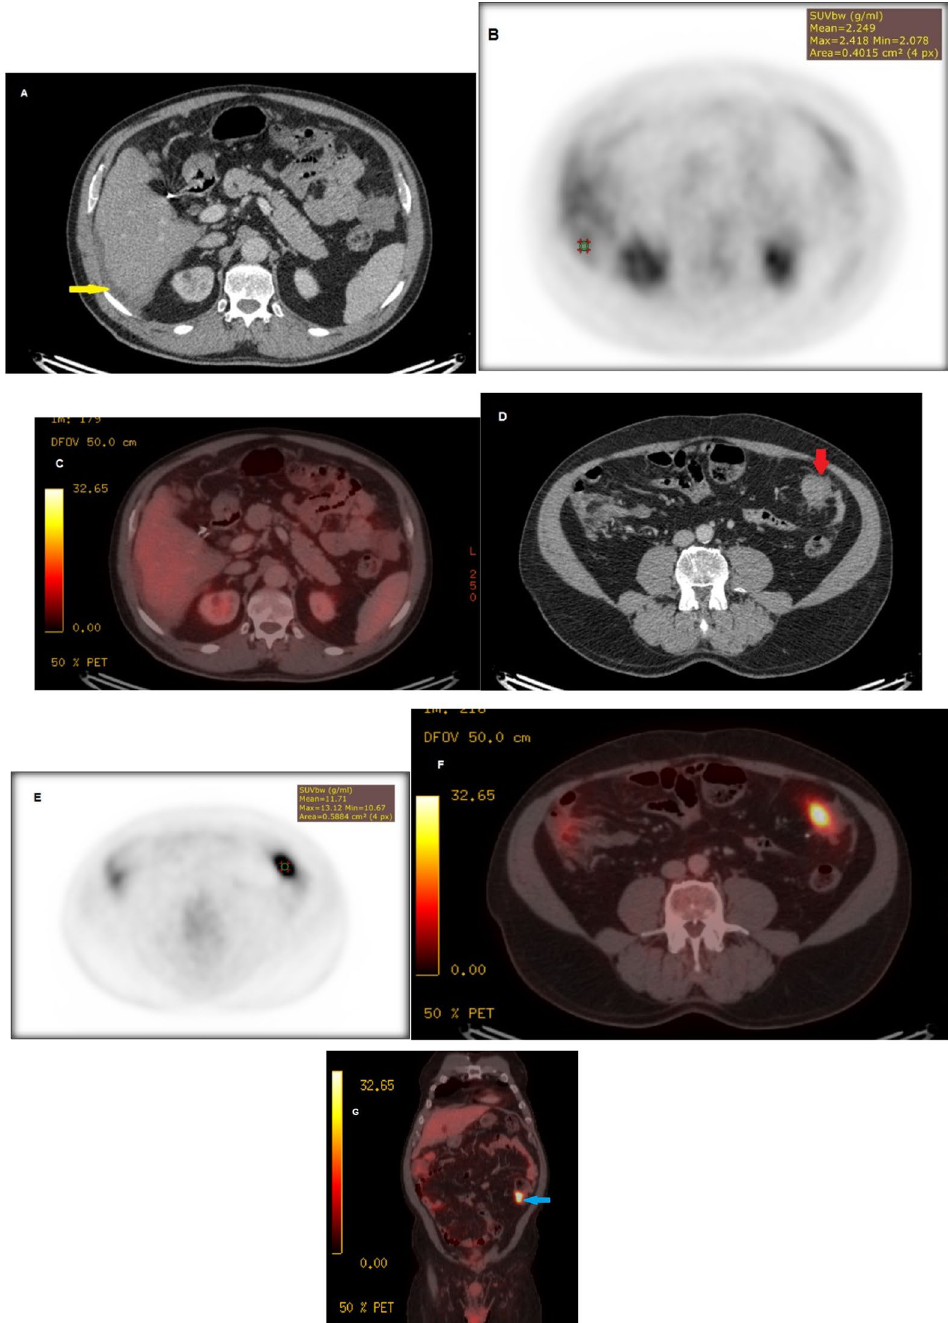
Fig. 8 A 68-year-old male patient with a history of colonic carcinoma under chemotherapy pathologically proved low-grade mucinoid adenocarcinoma, referred for follow-up. A Axial contrast-enhanced CT. B Axial PET slice at the same level. C Corresponding axial fused PET/CT image, showing peritoneal sheets and thickening seen along hepatic peritoneal surfaces scalloping its outline (yellow arrow) with low FDG uptake SUVmax ~ 2.4. Also, few scattered small nodules in the abdominal cavity underneath the anterior abdominal wall, inseparable from underlying = small and large bowel loops of low FDG uptake. D Axial contrast-enhanced CT. E Axial PET slice at the same level. F Corresponding axial fused PET/ CT image, showing irregular mural thickening of the distal part of the descending colon with focal soft tissue mass formation (red arrow) with intense metabolic activity eliciting SUVmax ~ 13. G Coronal PET/CT image demonstrating increased activity of the descending colon mass lesion = (blue arrow) with low activity of the peritoneal deposits on the liver serosal